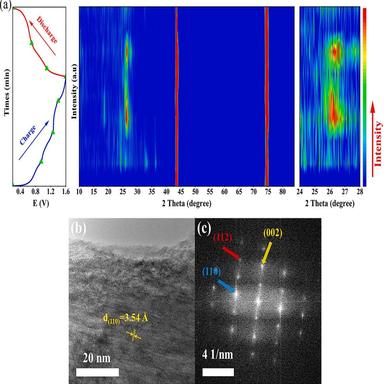
(a) Ex-situ XRD patterns of V2O3@CCN-15/2 composites collected at the various charge/discharge states for Zinc ions storage and enlarged views of the diffraction peak. (b-c) HRTEM and electron diffraction of V2O3@CCN-15/2 composites electrode after secondly discharging to 0.2 V.